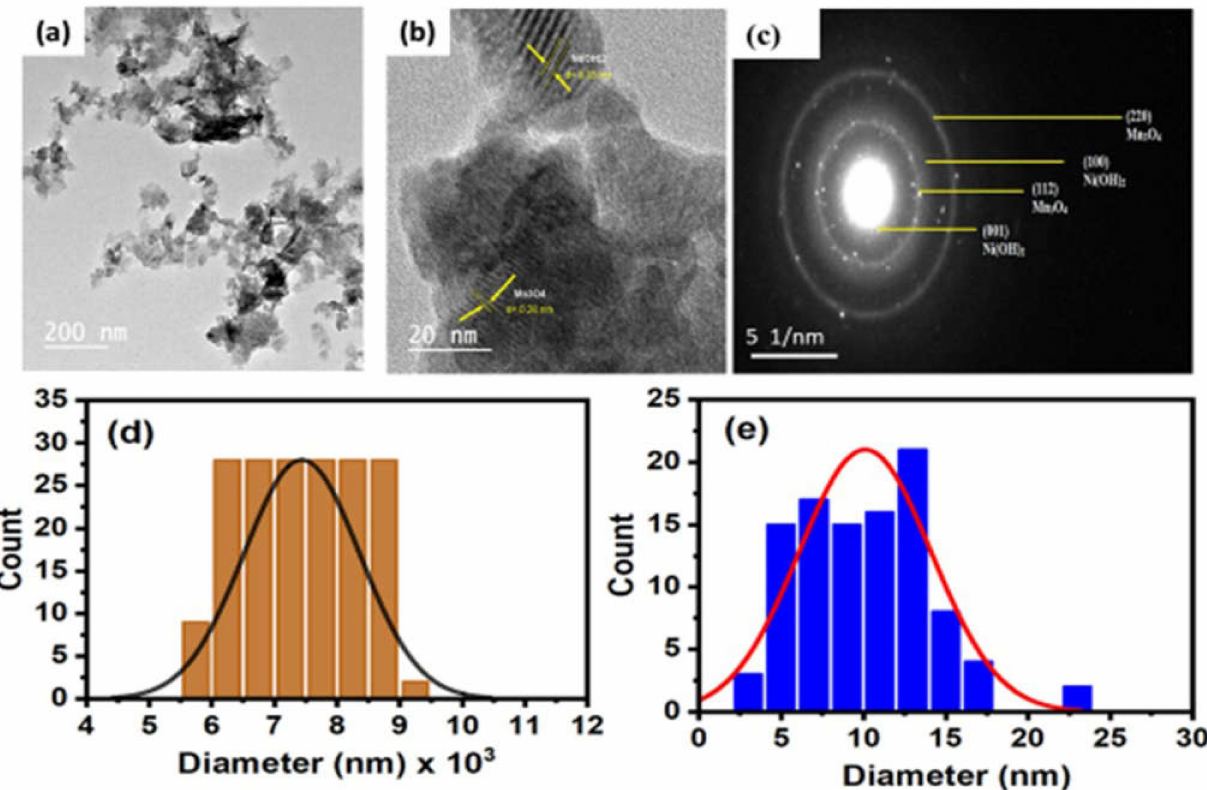
Figure 3. ( a ) TEM image ( b ) HR-TEM image of the composite with lattice fringes ( c ) Selected electron area diffraction pattern (SEAD), Particle size distribution calculated from ( c ) DLS analysis, ( d ) TEM analysis for Ni(OH) 2 @Mn 3 O 4 -NC and ( e ) Particle size distribution from TEM for Ni(OH) 2 @Mn 3 O 4